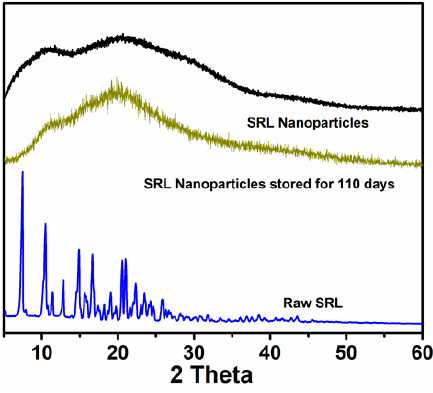
Figure 7. XRD patterns of raw SRL, SRL nanoparticles, and SRL nanoparticles stored for 110 days.